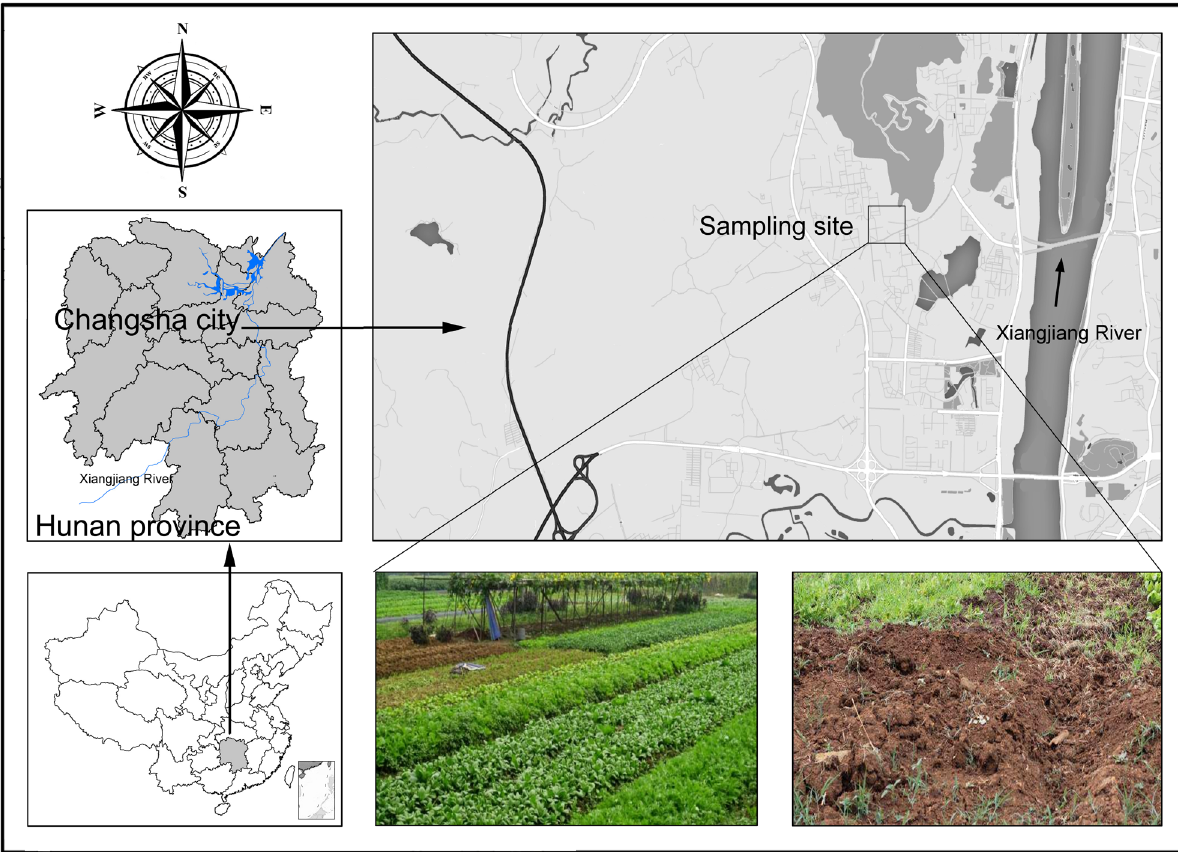
Figure 1: Location of the study area and sampling